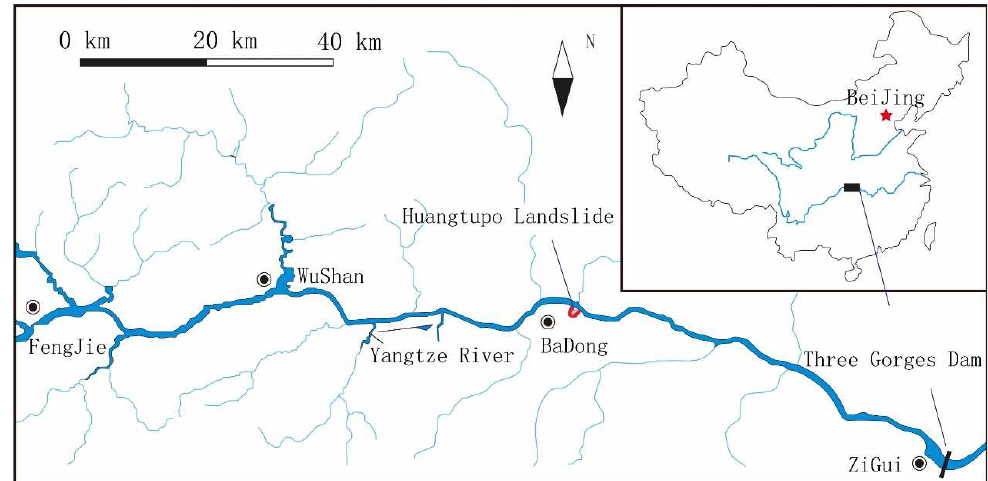
Figure 1. Location of Huangtupo landslide in China.